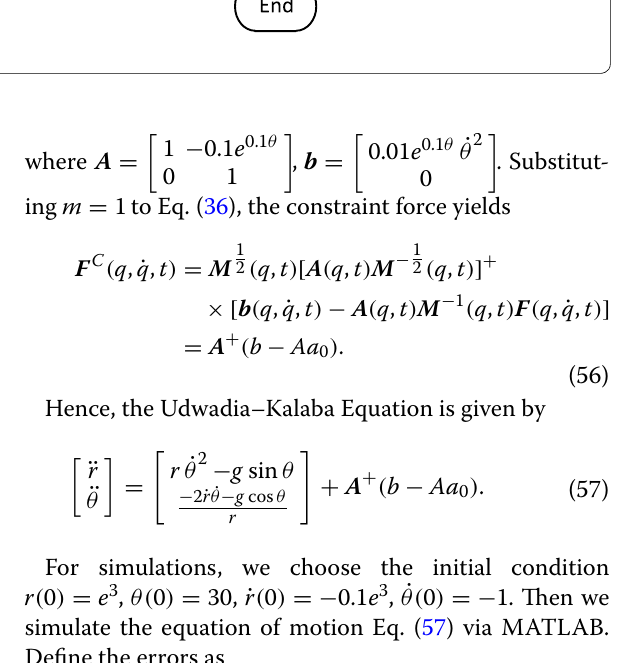
Figure 1 Formulation procedure of Udwadia–Kalaba